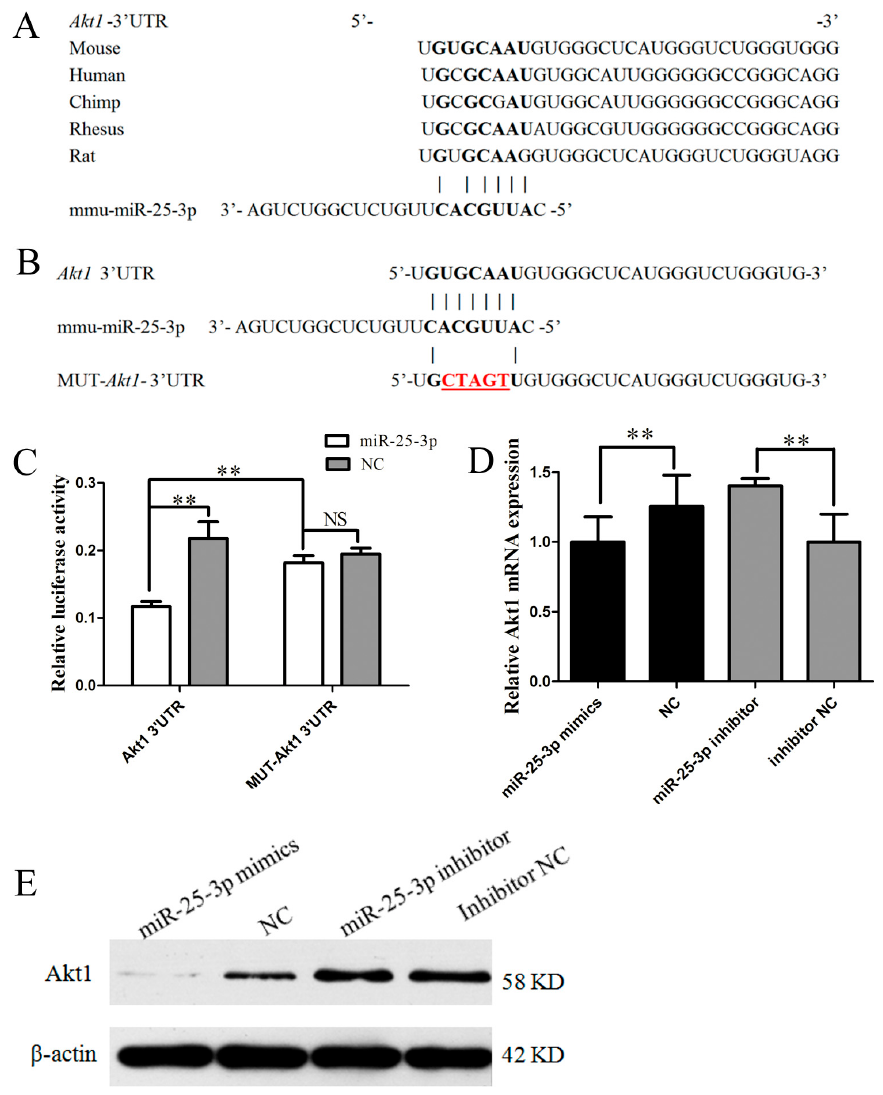
Figure 3. miR-25-3p directly targets the 3 ′ UTR of Akt1 . ( A ) The sequences of miR-25-3p target